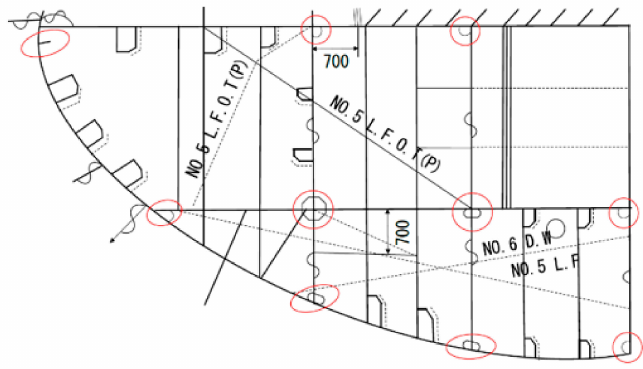
Figure 7. Pressure test position marks in